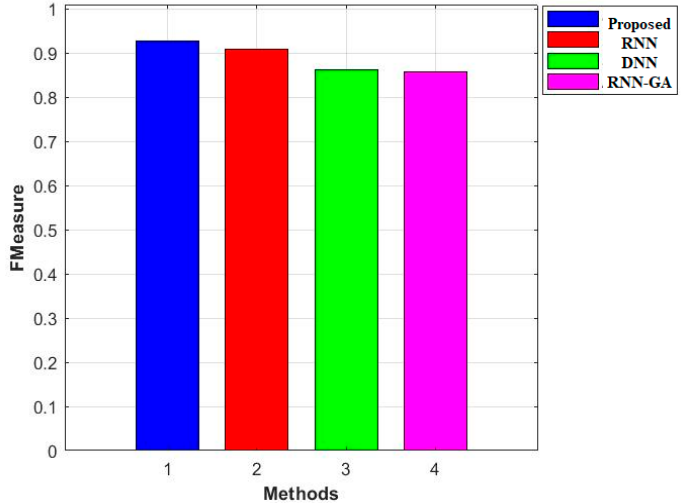
Figure 9. F measure performance of confusion matrix.